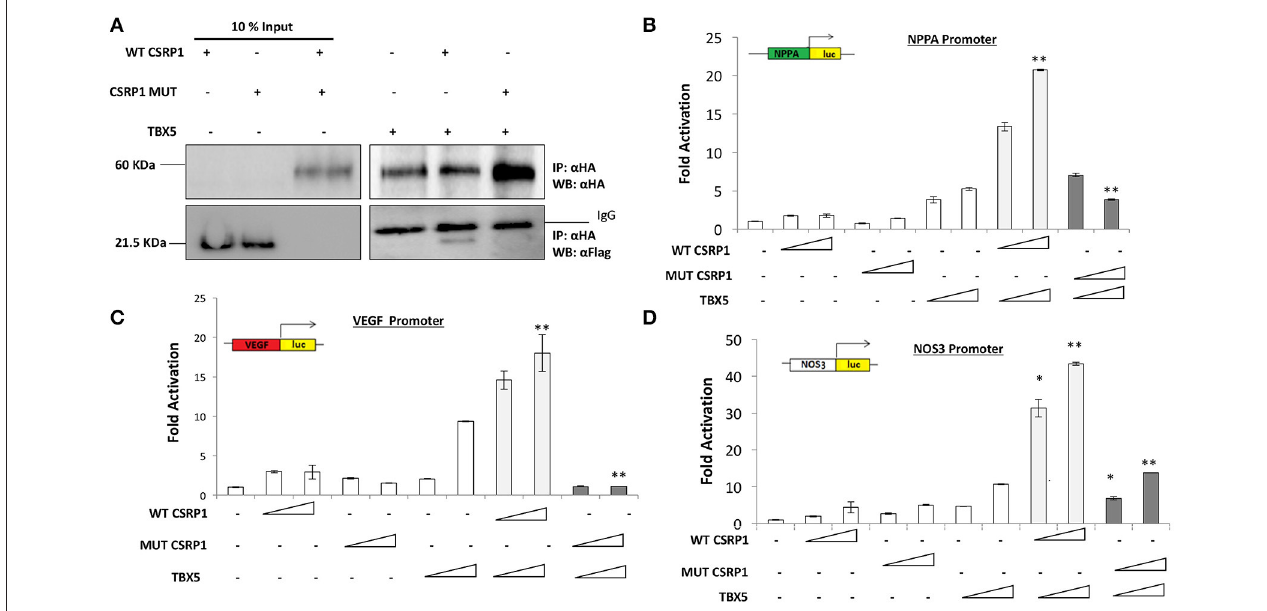
FIGURE 5 | The effect of p.E154Vfs*99 mutation on the physical and functional interaction between CSRP1 and TBX5. (A) Physical interaction between HA-tagged TBX5 and Flag-tagged CSRP1 (WT and MUT) is demonstrated in the lanes of the right panel The amount of the proteins used for immunoprecipitation was 10 times that used in western blot. Nuclear lysates of CSRP1 protein was immunoprecipitated with anti-HA antibody and CSRP1 proteins were detected using anti-Flag antibody. After membrane stripping, subsequent western blot analysis using anti-HA was performed to detect TBX5 protein. (B–D) Transcriptional activity of WT and/or MUT CSRP1 along with TBX5. WT or MUT CSRP1 were transiently cotransfected with TBX5 along with NPPA, VEGF, and NOS3-luciferase promoters respectively in HEK293 cells. Relative luciferase activities were presented as fold changes. The data represent the means of 3 independent experiments done in duplicates and the values are ± SE. P -value was assessed used Students’ T -test. Significance p < 0.01 is indicated by (**), while p < 0.05 is indicated by (*); significance of synergy for WT is tested relative to the sum of individual activations, while that of mutant is tested relative to synergy The triangle represents an increasing dose of the WT and MUT CSRP1 (400 and 600ng, respectively) and TBX5 (200 and